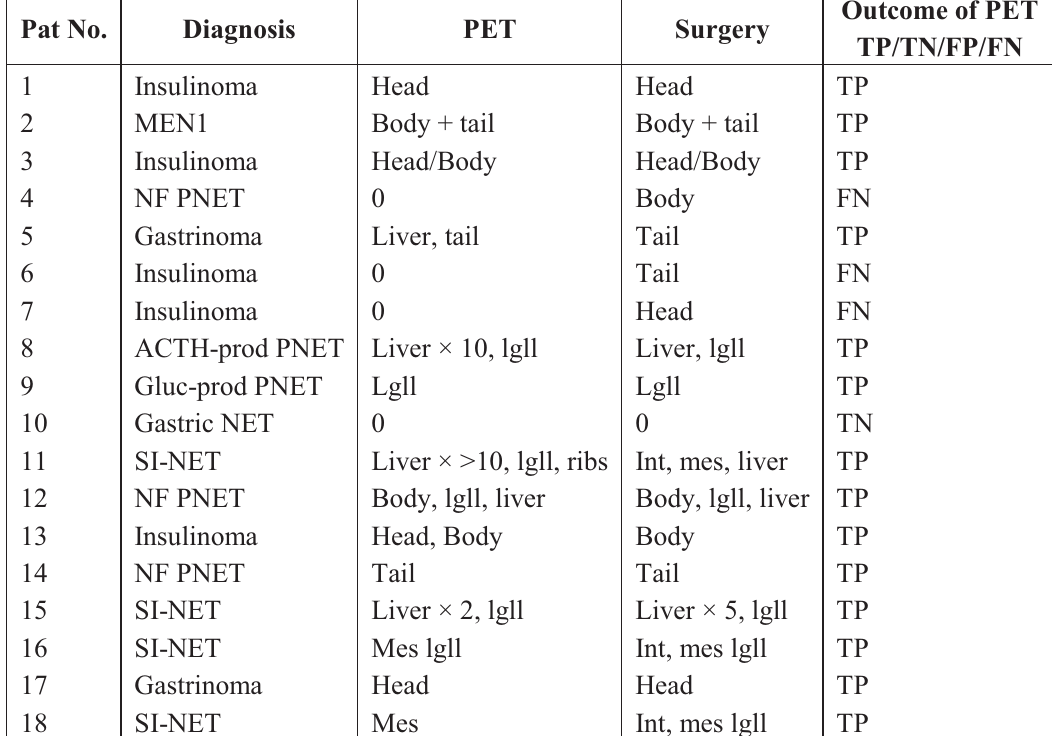
Table 2. List of patients subjected to 11 C-5-HTP PET before surgery, short notes for the PET and intraoperative findings, and commented